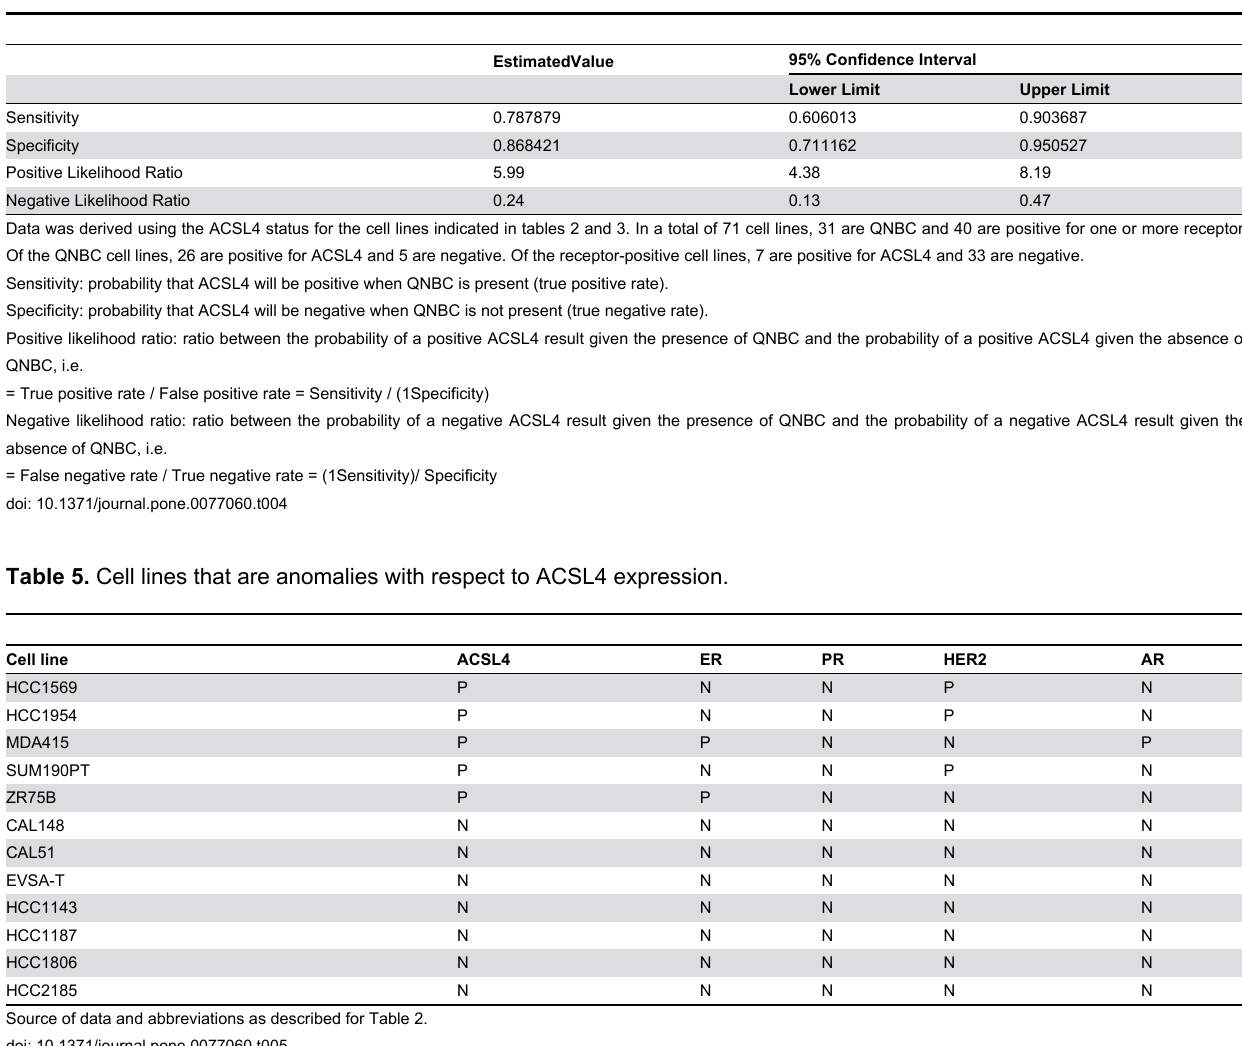
Table 4. Predictive value of ACSL4 as a marker for QNBC in breast cancer cell lines.